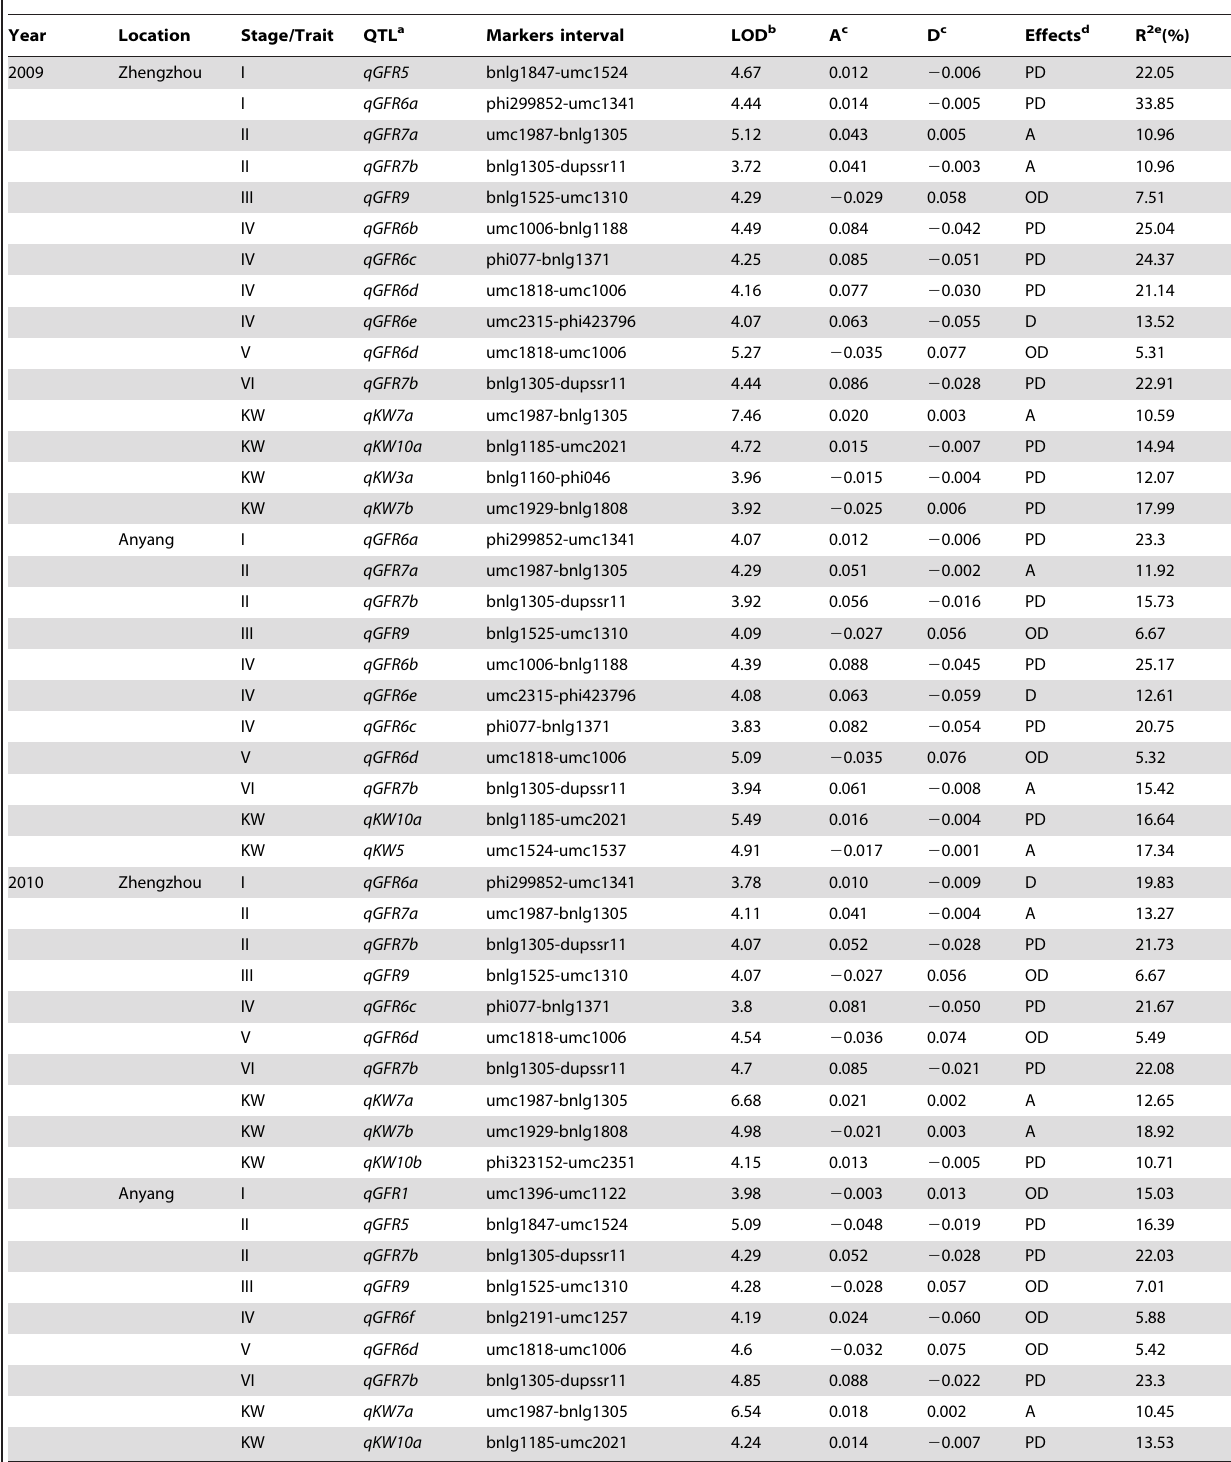
Table 3. Unconditional QTLs detected for grain filling rate in the immortalized F 2 population.